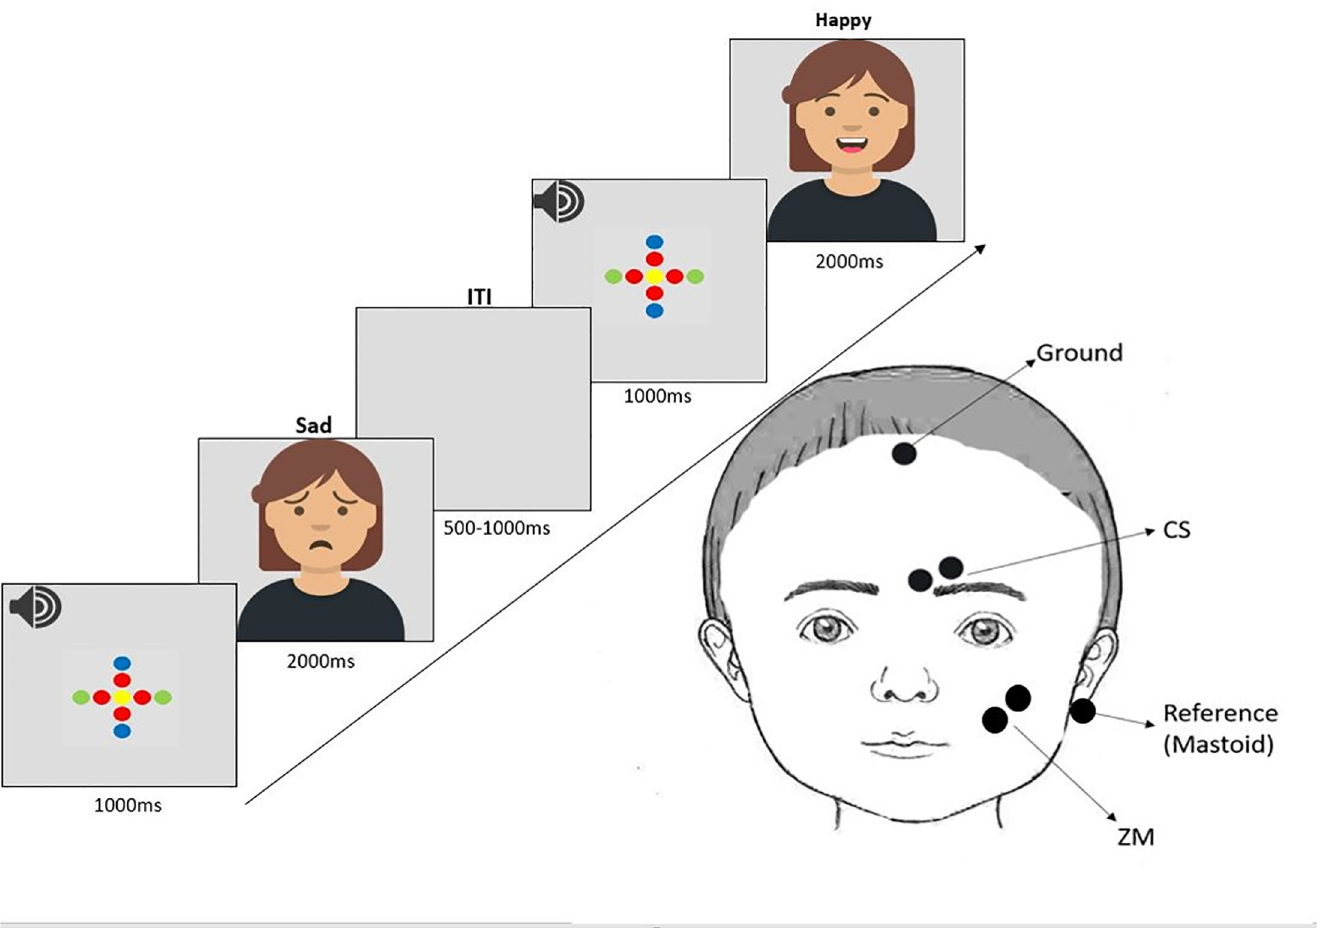
Fig 1. Study design and EMG paradigm. Study design illustrating the trials presentation during facial electromyographic (EMG) recordings over the zygomaticus major muscle (smiling) and the corrugator supercilii muscle (frowning). The example stimuli are not the original images used in the study, due to copyright license of the stimuli from the Radboud Faces Database. The avataars were created and used here for illustrative purposes only (https://getavataaars.com).